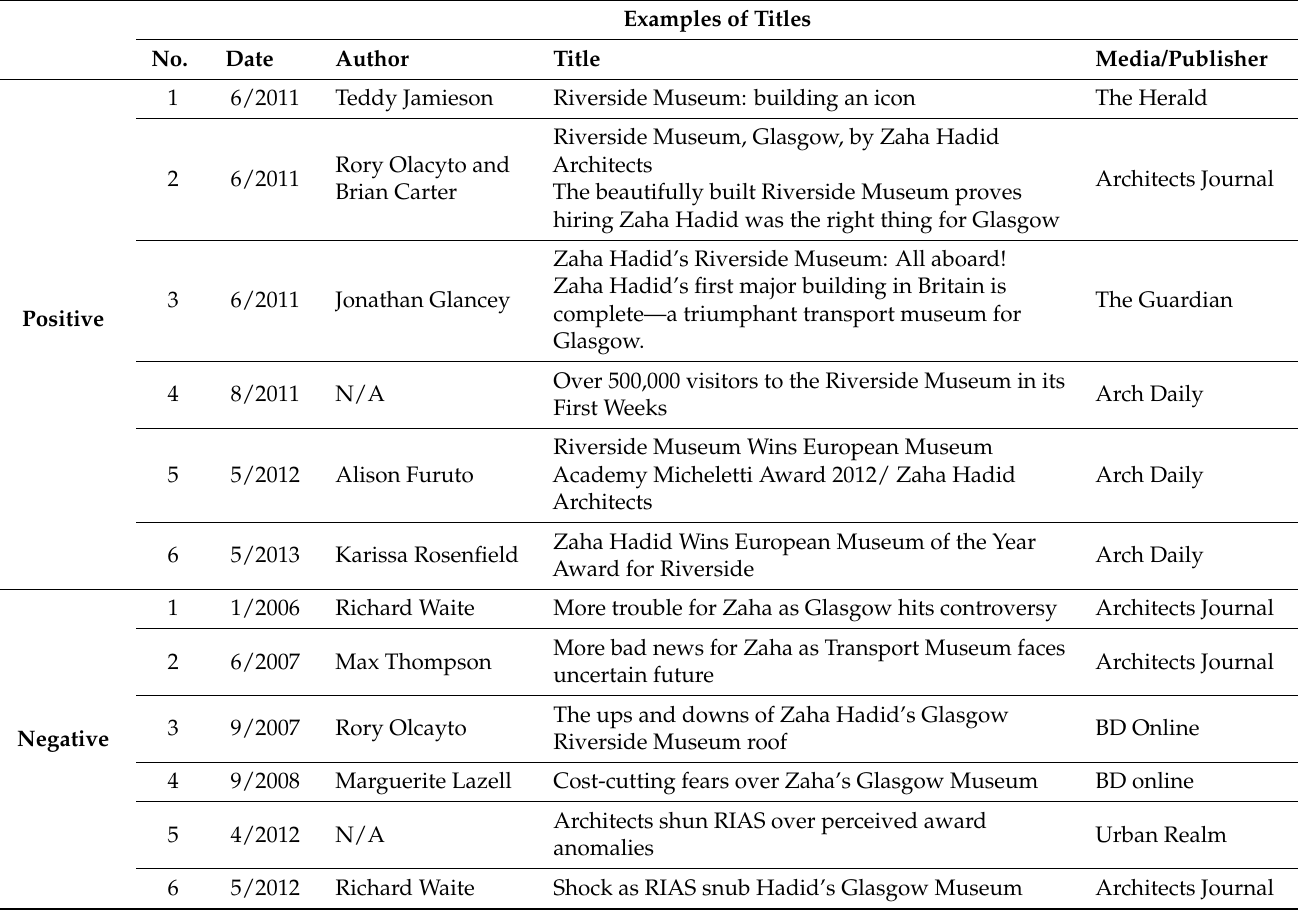
Table 3. Titles used in the press to describe the Riverside Museum in Glasgow.